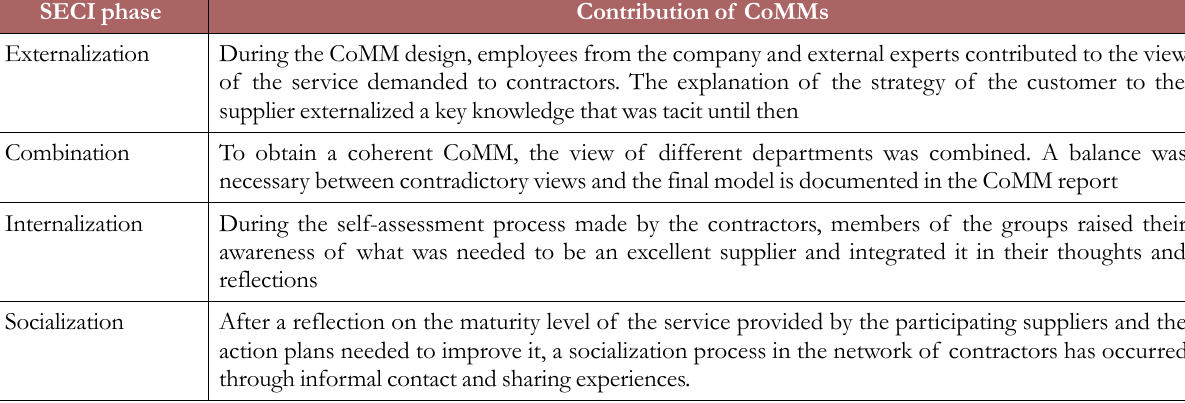
Table 1. Contribution of CoMMs to SECI knowledge creation spiral proposed by Nonaka and Takeuchi